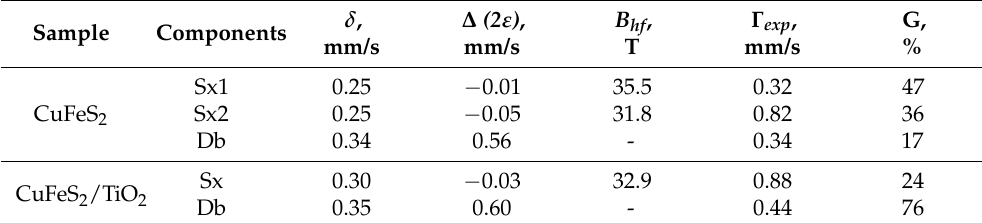
Table 1. Mössbauer values of CuFeS 2 and CuFeS 2 /TiO 2